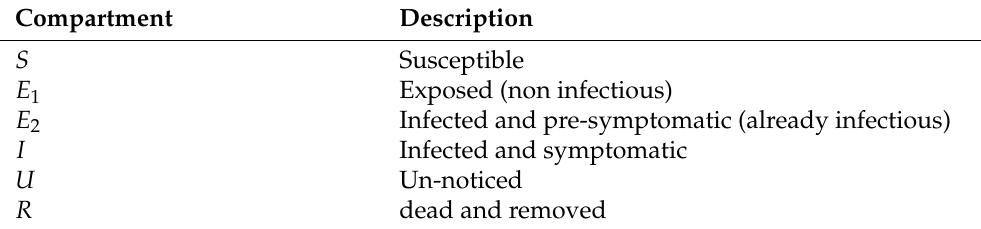
Table 3. Description of the compartments in model SE 2 IUR .